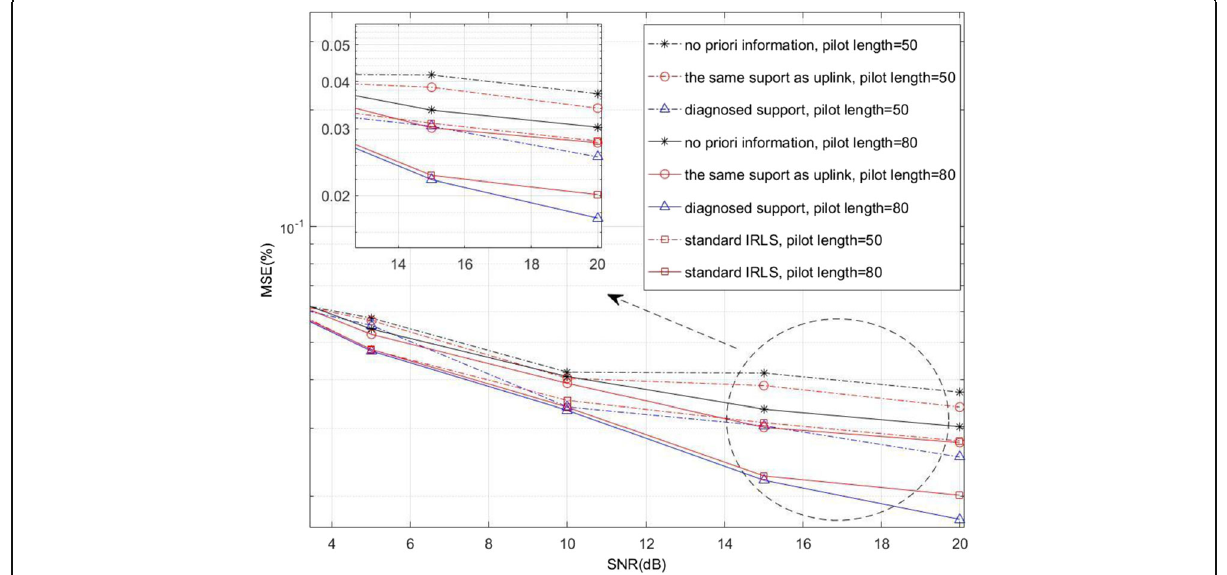
Fig. 5 Weighted SP recovery based on the diagnosed supports with different pilot